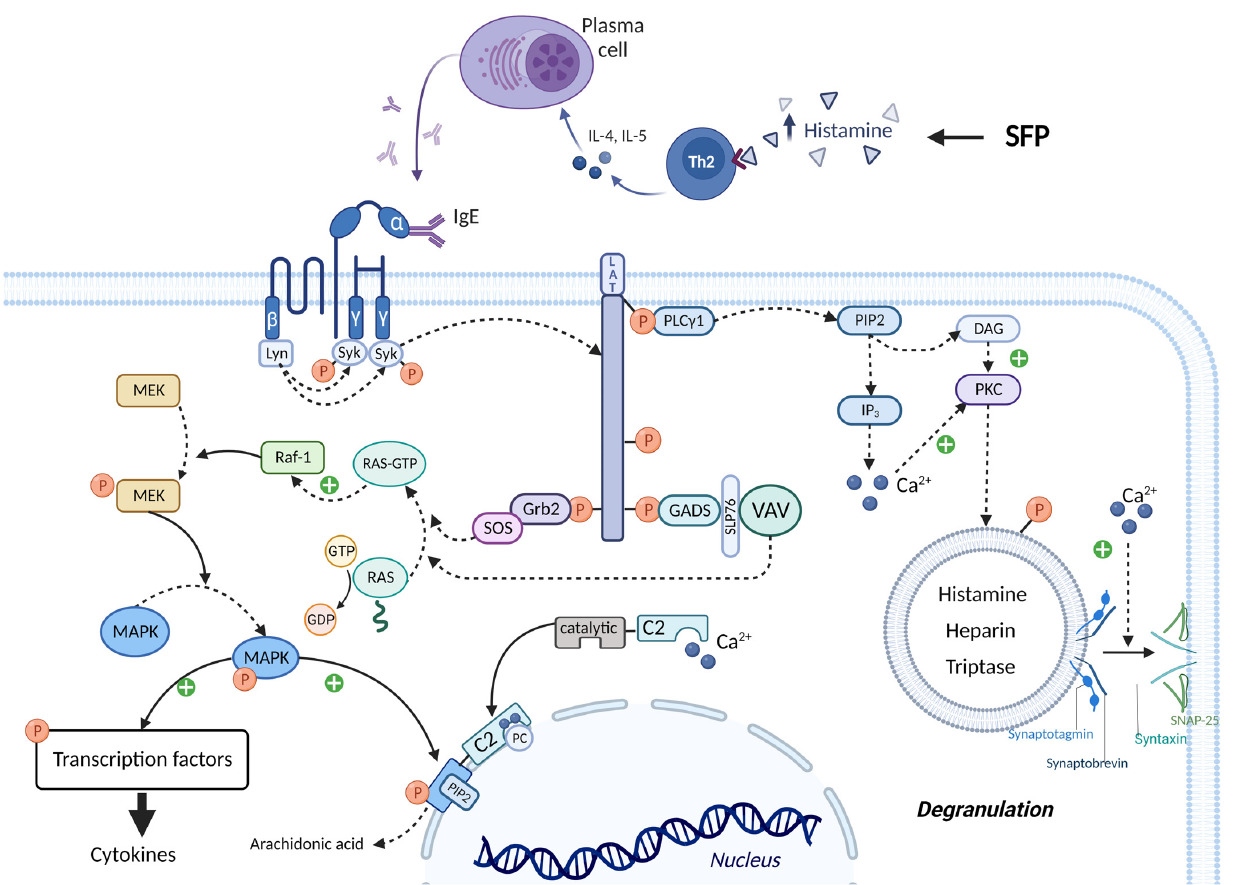
Figure 7. IgE-mediated activation of mast cells in SFP. IgE binds to the Fc ε RI receptors and leads to the activation of Lyn and Syn. Syn phosphorylates LAT, thereby creating a platform for recruitment of Grb2, GADS, and PLC γ 1. Grb2 and GADS activate biochemical cascades which lead to MAPK activation and cytokines production. PLC γ 1 activates IP 3 system and leads to the mast cell degranulation and arachidonic acid production. ITAMs—immunoreceptor tyrosine-based activation motifs, SH2—Src homology domain, LAT—linker for activation of T cells, GADS—GRB2-related adaptor protein, GRB2—growth-factor receptor-bound protein 2, PLC γ 1—phospholipase C γ 1, SOS—the Son of Sevenless, GEFs—guanine nucleotide exchange factors, RAF-1—proto-oncogene serine/threonine-protein kinase, MEK—MAPK/ERK kinase, MAPK—mitogen-activated protein kinase, SLP76—SH2-domain-containing leukocyte protein of 76 kDa, cPLA2 α —cytoplasmic phospholipase A2 α .